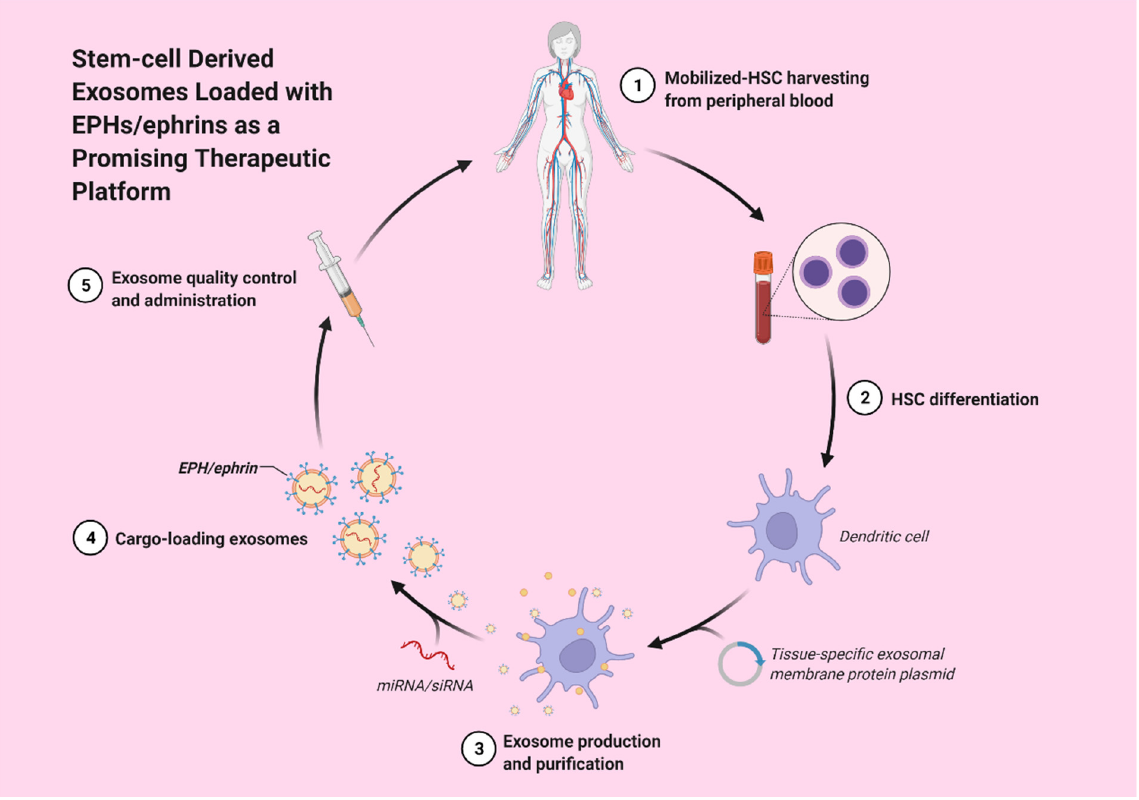
Figure 2. Stem-cell derived exosomes loaded with EPHs/ephrins could potentially act as a promis- ing therapeutic strategy.